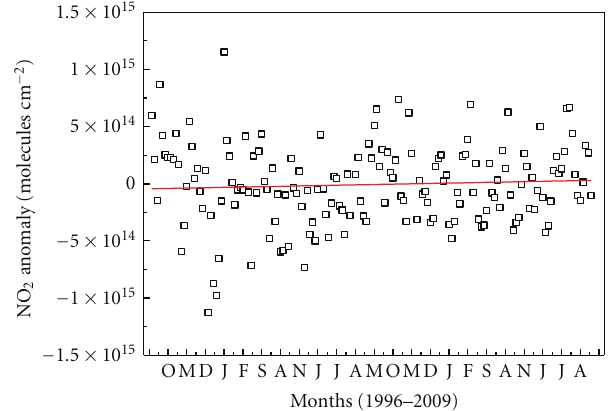
Figure 10: Monthly normalized NO 2 over NE plotted for the period April 1996–December